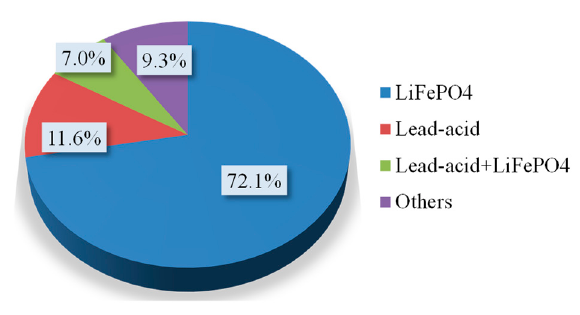
Figure 7. Proportion of electrochemical energy storage technologies.